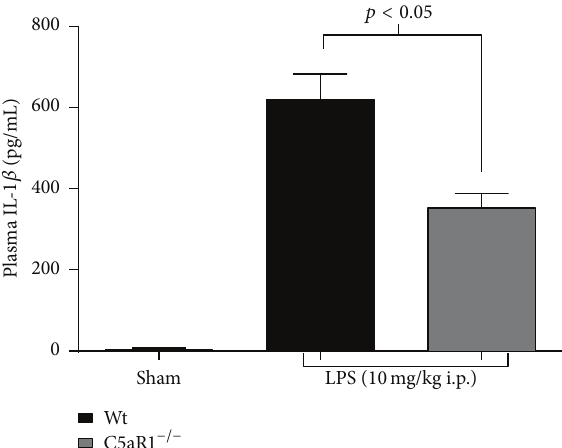
Figure 1: C5aR1 augments the IL-1 𝛽 response during LPS-induced endotoxemia. Wild-type and C 5 aR 1 −/− mice ( 𝑛 ≥ 5 mice per group) were injected i.p. with LPS (10mg/kg body weight) and plasma was harvested after 8 hours. IL-1 𝛽 production was determined by ELISA with plasma protein levels expressed as means ± standard error of the mean. Results showed that a loss of C5aR1 in vivo attenuates the LPS-activated IL-1 𝛽 response. Wt = wild